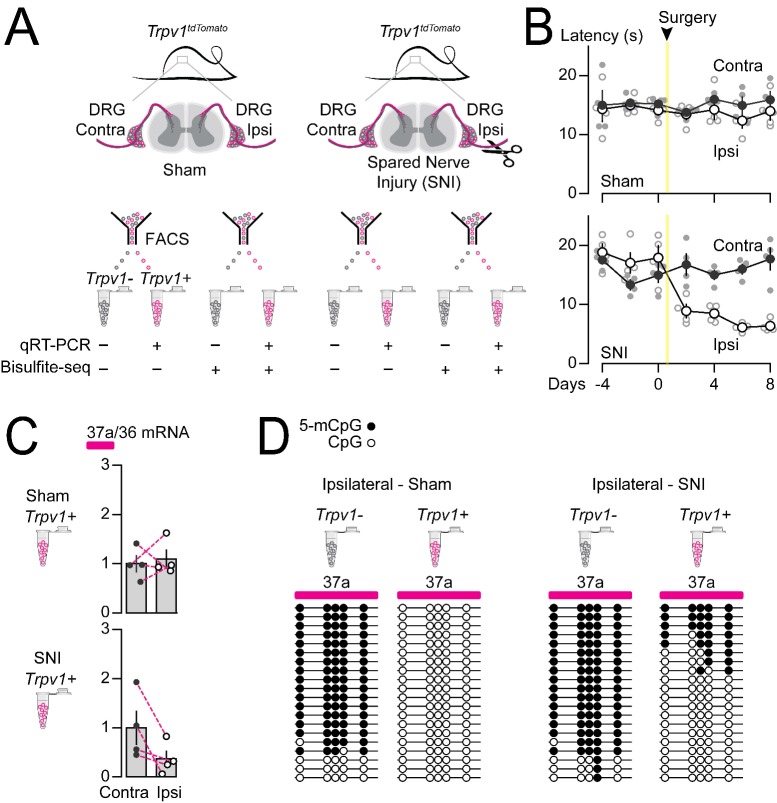
Methylation in Cacna1b e37a locus increased and e37a inclusion decreased in Trpv1-lineage neurons following peripheral nerve injury.(A) Spared nerve injury (SNI) model was used to induce prolonged hyperalgesia in Trpv1TdTomato mice. Behavioral assessments are shown in B. Trpv1-lineage and non Trpv1-lineage cells of contralateral and ipsilateral L3 and L4 DRG from Sham and SNI mice were separated by FACS. Trpv1-lineage neurons were analyzed by qRT-PCR in C, and Trpv1-lineage and non Trpv1-lineage cells pooled from three mice per condition for bisulfite sequencing in D. (B) Thermal sensitivity assessment of mice prior to, and 8 days after surgery. Plantar, hind paw withdrawal latencies measured in response to a radiant heat source both ipsilateral and contralateral to the site of surgery in sham and SNI mice. SNI mice developed hyperalgesia in ipsilateral but not contralateral hind paws (two-way ANOVA P value = 0.0173 for side to the surgery factor, and P value = <0.0001 for time factor). By contrast, sham surgery had no effect on paw withdrawal latencies in response to heat source (two-way ANOVA P value = 0.2136 for side to the surgery factor, and P value = 0.7780 for time factor) (four biological replicates per condition). (C) qRT-PCR of e37a relative to e36 in Trpv1-lineage neurons. Dotted lines connect contra and ipsilateral L3 and L4 DRG values from the same animals (Paired t-test P values for contra vs ipsilateral DRG = 0.3671 from sham, and P value = 0.0384 from SNI mice) (four biological replicates per condition). (D) Methylation state of 5 CpG sites in Cacna1b e37a locus in non Trpv1-lineage and in Trpv1-lineage neurons from L3 and L4 DRG ipsilateral to the site of surgery for sham (left) and SNI (right) mice. Methylated (5-mCpG, filled circle) and unmethylated (CpG, open circle) sites are shown for independent clones ordered from most to least methylated. Each set of sequences represents data pooled from L3 and L4 DRG from three animals, for a total of 6 animals per condition. Biological replicates are independent mice.